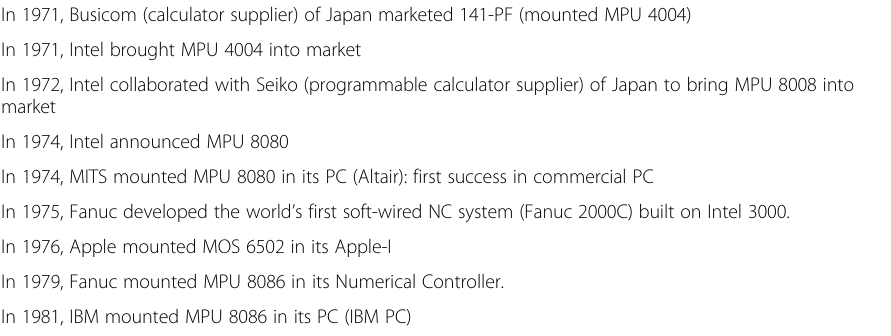
Table 1 Chronology of mounting MPU in their